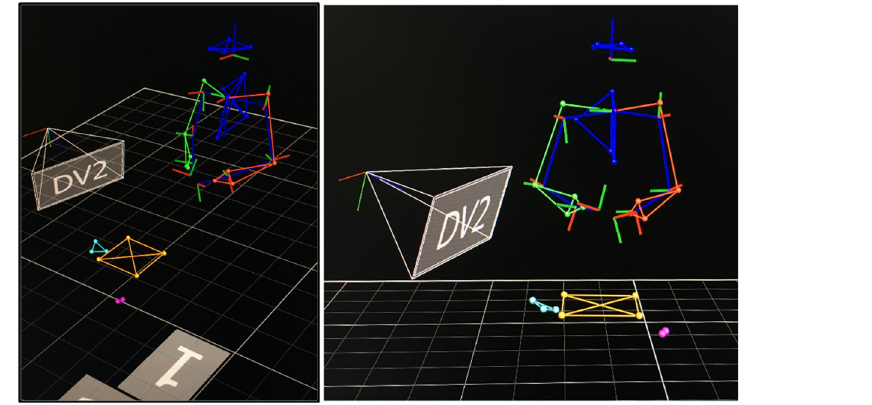
Fig 3. Marker reconstruction in 3D motion capture